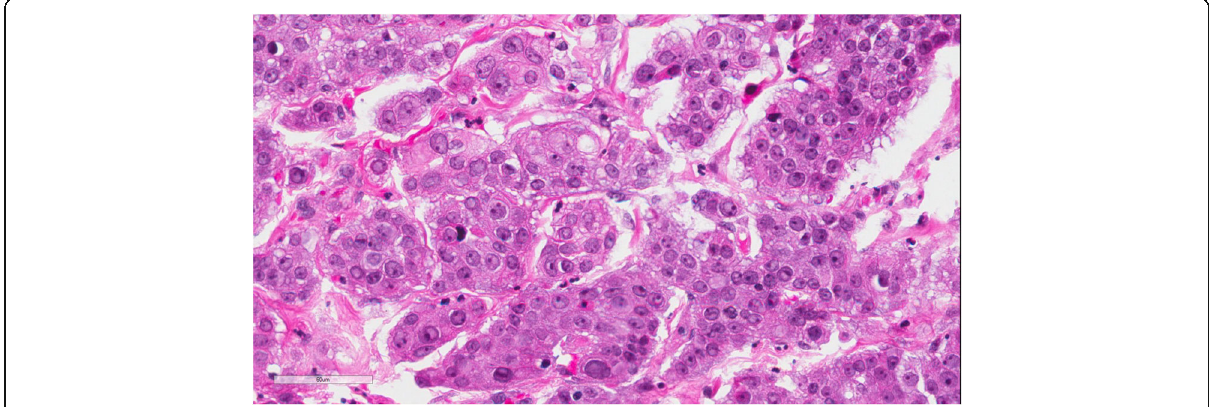
Fig. 6 H & E on high magnification (40x) showing pleomorphic tumor cells with enlarged, hyperchromatic nuclei and prominent